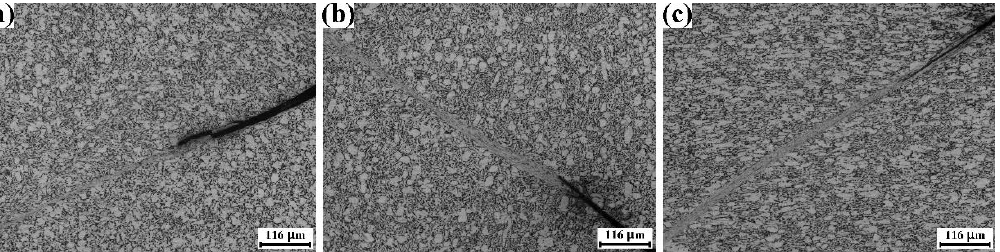
Figure 7. Optical micrographs of the mill-annealed Ti-6Al-4V alloy plate after the dynamic compression test. The loading direction is vertical. ( a ) Ruptured RD specimen, ( b ) ruptured TD specimen, ( c ) ruptured ND specimen.